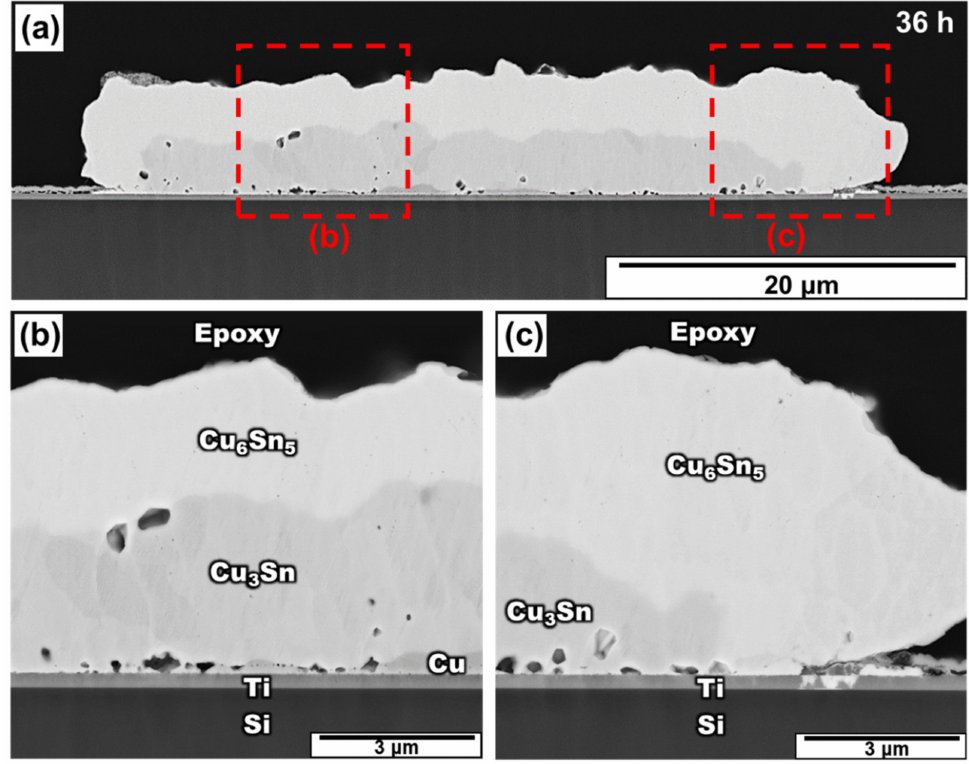
Figure 4. ( a ) Cross-section SEM image of the Sn/Cu micro-bump after aging at 200 ◦ C for 36 h and the zoomed-in image in a region near the ( b ) middle region and ( c ) right